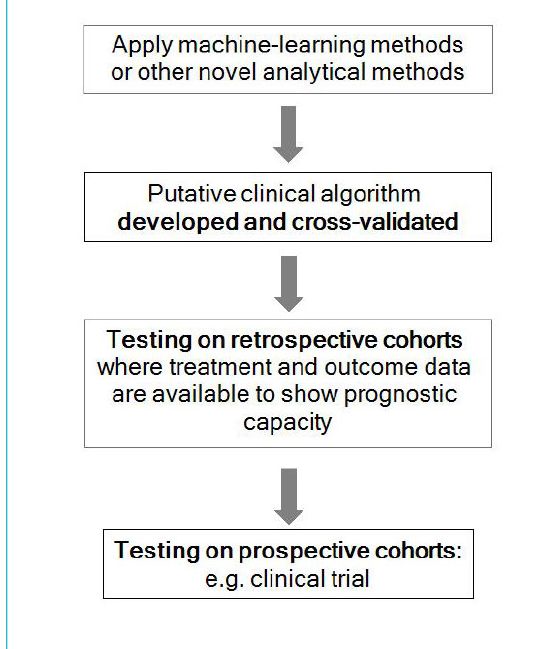
Figure 2: Developing and translating clinical computational tools. Having genomic and clinical data that are well-structured and organised is essential for the efficient development of novel clinical algorithms. Once putative clinical algorithms are devel- oped, the critical next steps towards fully translating the algorithm is to apply it into retrospective and prospective clinical